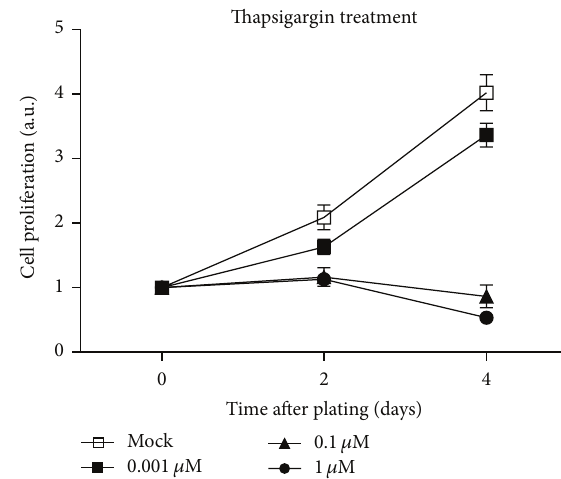
Figure 1: Thapsigargin inhibits MH7A cell proliferation. His- tograms showed that the cell proliferation is impaired after thap- sigargin treatment (0.001, 0.1, and 1 𝜇 M) in MH7A cells, by (SRB) colorimetric assay. Results are averages of three independent exper-